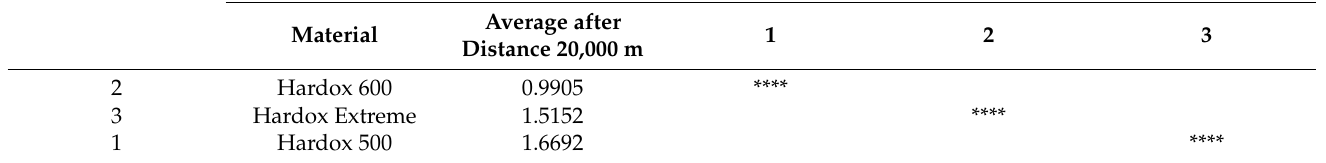
Table 6. The results of the statistical analysis of the differences between the average wear values for particular materials in the heavy